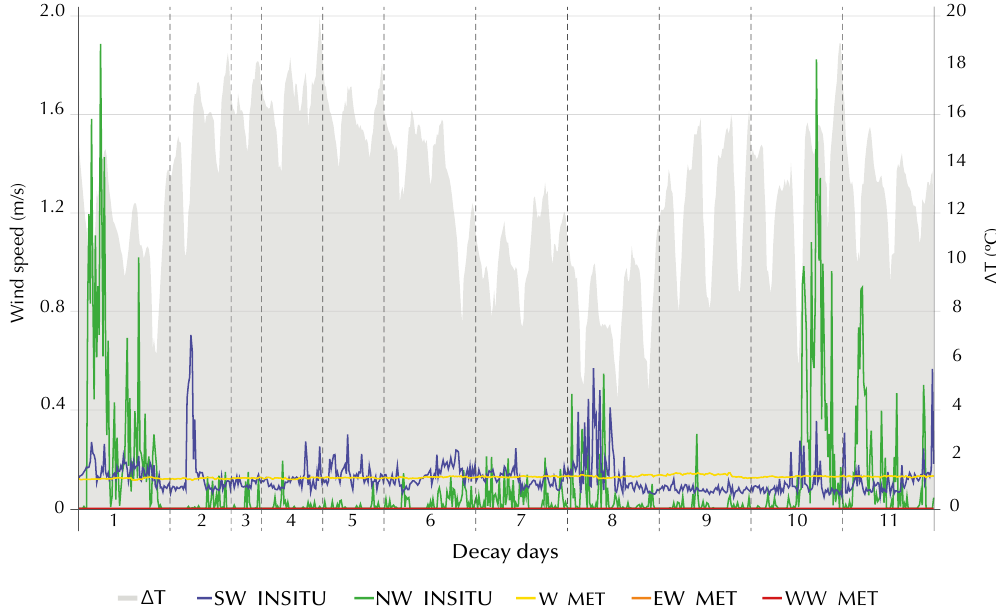
Figure 7. Wind speed and ∆ T averages of winter (P_2_C) at ten-minute time-step. Most days have practically the same wind rhythm pattern. In contrast to P_1_T, the weather station data are equal to zero or maintain the same value almost every day. In this figure, it is difficult to see the EW_MET because its curve is behind the